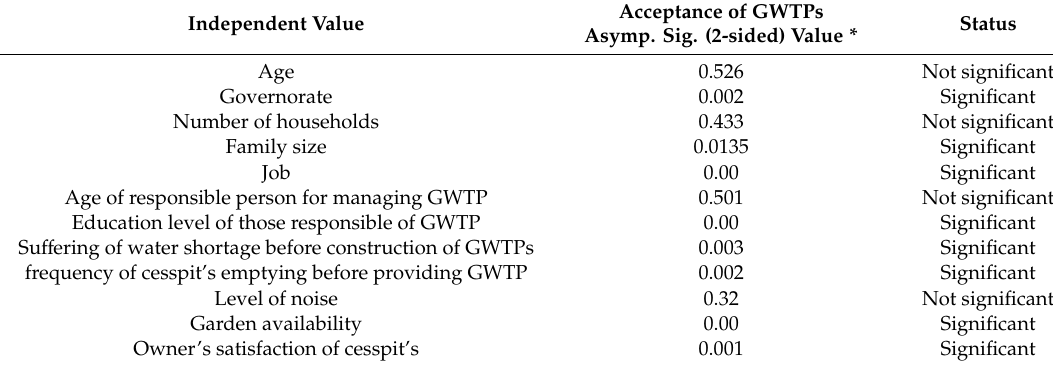
Table 1. Acceptance of providing GWTPs (grey water treatment plants) for reuse in irrigation. Table 2. Acceptance of GWTPs for reuse in irrigation per governorate.